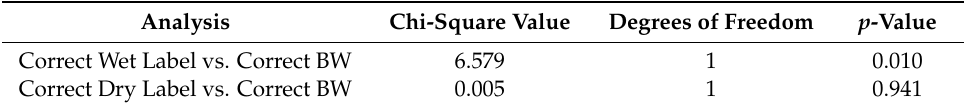
Table 3. Pearson’s chi-square test for the assessment of correct interpretation of pet food labels and the correct estimation of bodyweight (BW).